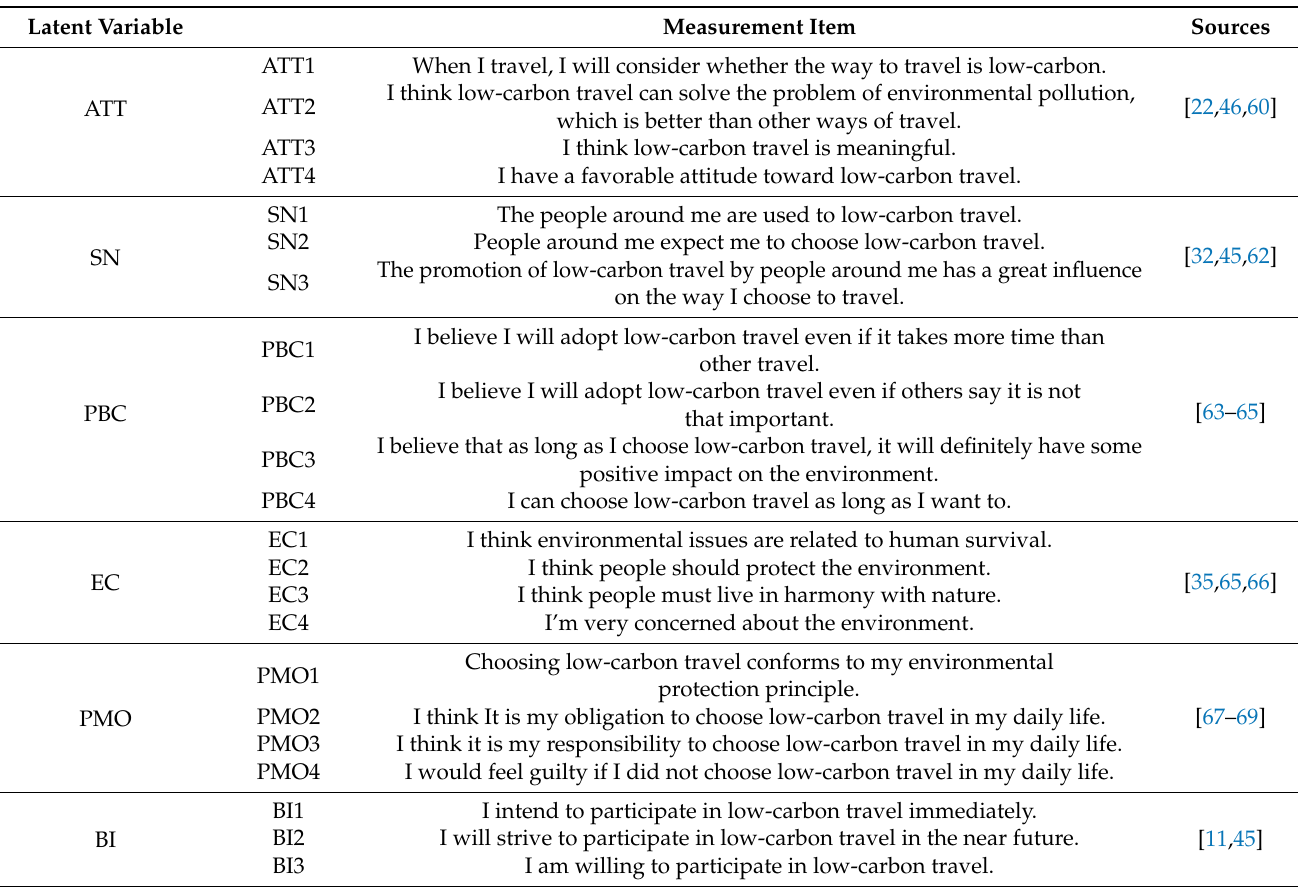
Table 1. Survey items of young people’s low-carbon travel